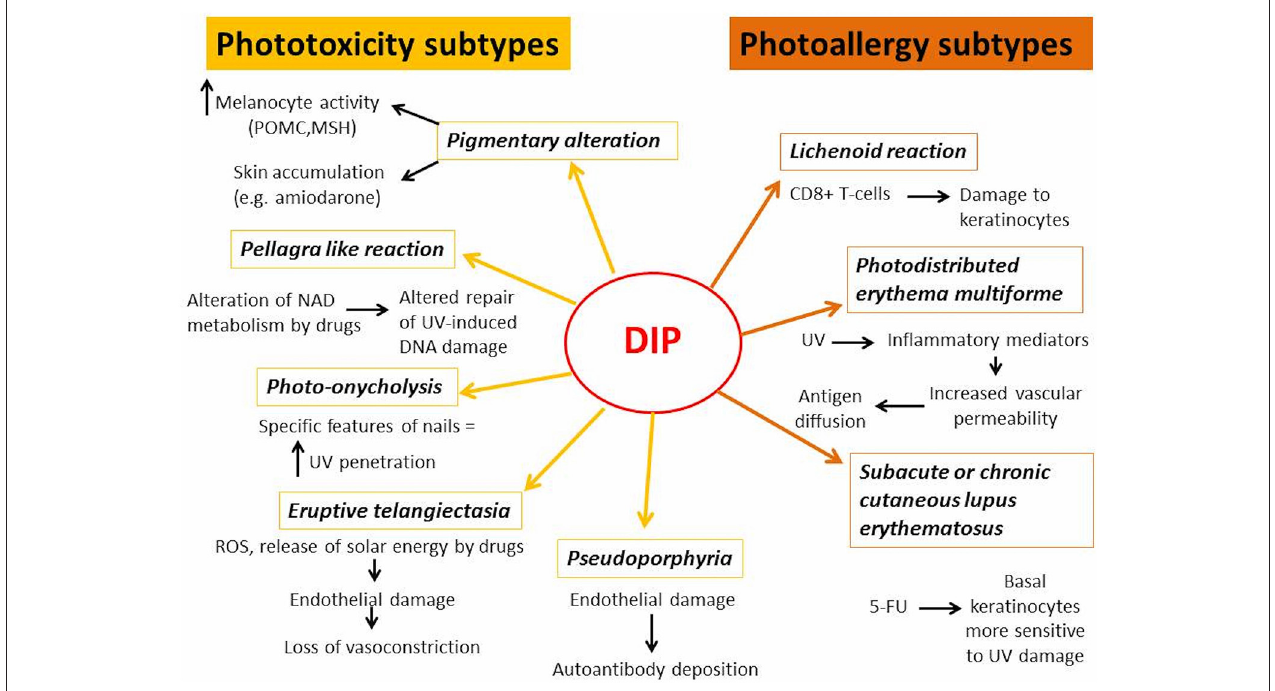
FIGURE 1 | Summary of pathogenetic mechanisms involved in